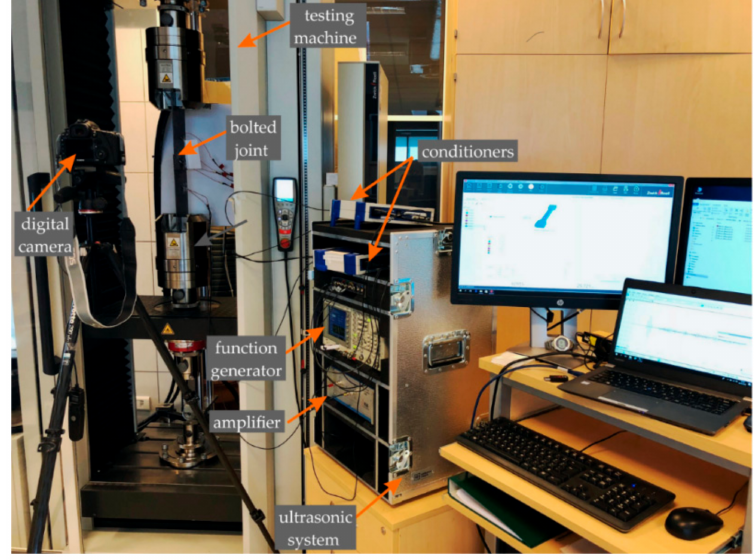
Figure 2. Test rig and instrumentation of the bolted joint under tensile loading for Lamb wave-based